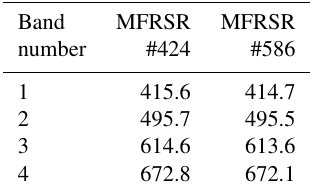
Table 1. Nominal central wavelengths (in nm) of the four bands used in the PAR estimate for the two MFRSR radiometers. The FWHM bandwidth is about 10nm for all